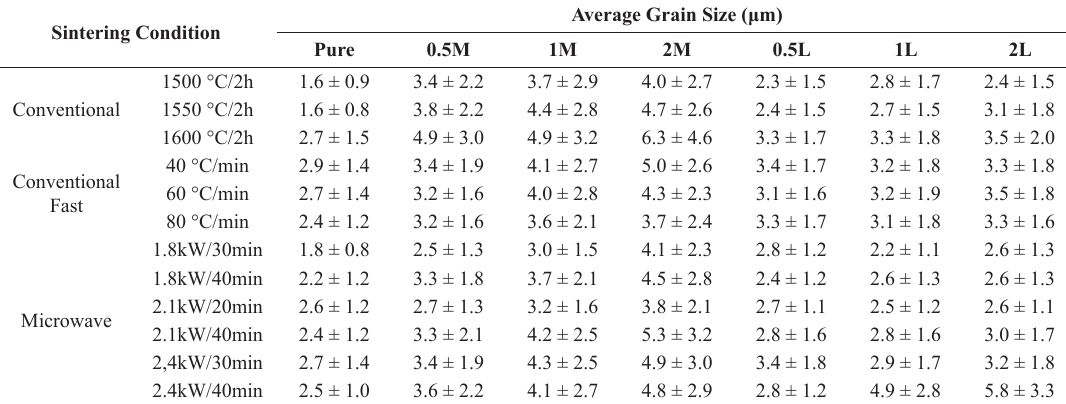
Table 1. Average grain size of conventionally and fast sintered samples.